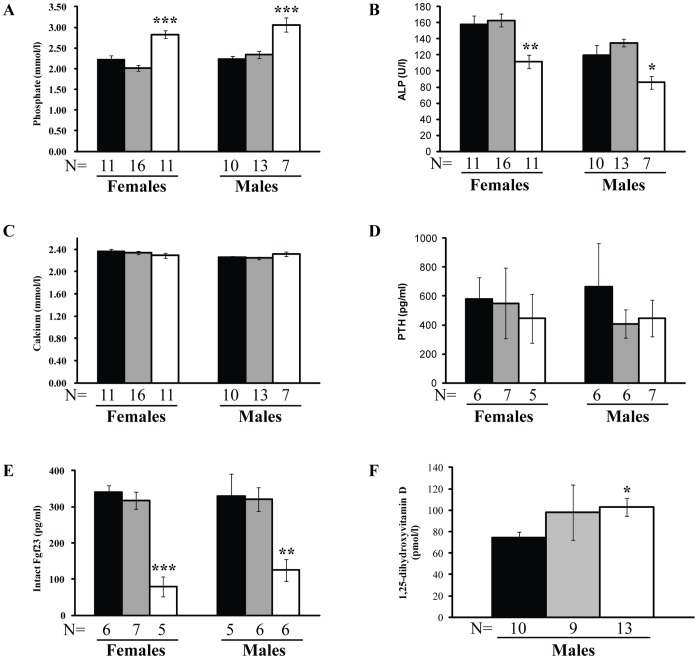
Plasma biochemical analyses.Plasma from WT littermates (+/+) (black), Tcal/+ (grey) and Tcal/Tcal (white) adult mice, aged 10 weeks was obtained and used to measure plasma concentrations of (A) phosphate, (B) alkaline phosphatase (ALP) activity, (C) calcium (adjusted for albumin concentrations), (D) PTH, (E) intact Fgf23, and (F) 1,25-dihydroxyvitamin D. Tcal/Tcal mice but not Tcal/+ mice, had: hyperphosphataemia, reduced alkaline phosphatase activity, reduced plasma concentrations of intact Fgf23, and elevated circulating concentrations of 1,25-dihydroxyvitamin D. The plasma concentrations of calcium and PTH were not significantly different. Sufficient volumes of plasma samples from female mice were not available for an analysis of 1,25-dihydroxyvitamin D concentrations; however, analysis of pooled samples from 2 WT female littermates, 3 Tcal/+ females, and 3 Tcal/Tcal females revealed that the plasma 1,25-dihydroxyvitamin D concentrations were 58.2 pmol/l, 55.7 pmol/l, and 71.7 pmol/l, respectively. These results indicate that the plasma 1,25-dihydroxyvitamin D concentrations in WT littermates and Tcal/+ females are similar, but are elevated in Tcal/Tcal females, and are consistent with the observations in male mice. The data are represented as mean ± SEM, and p-values are from unpaired Students t-test (*p<0.05, **p<0.01, ***p<0.001).